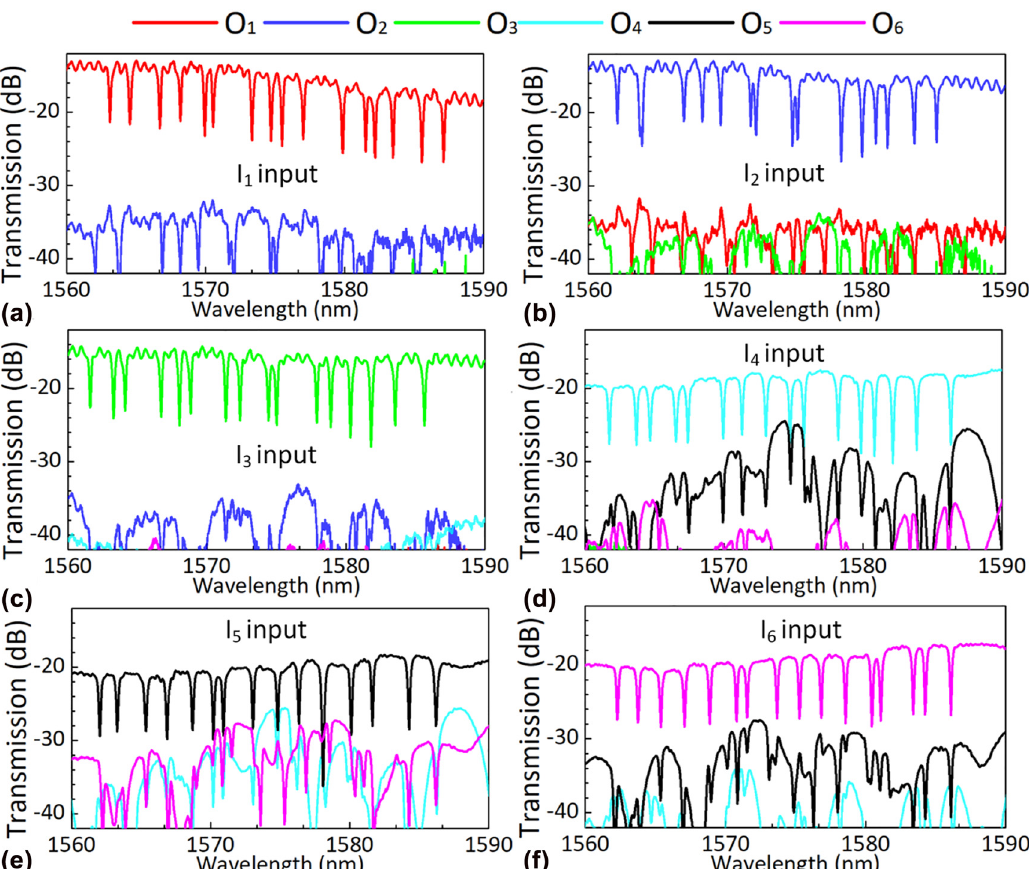
at the through port O